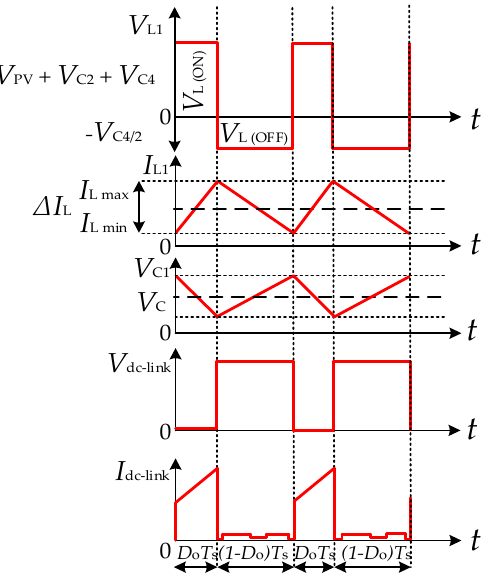
Figure 4. Key switching waveforms for the SL-SBZSI.